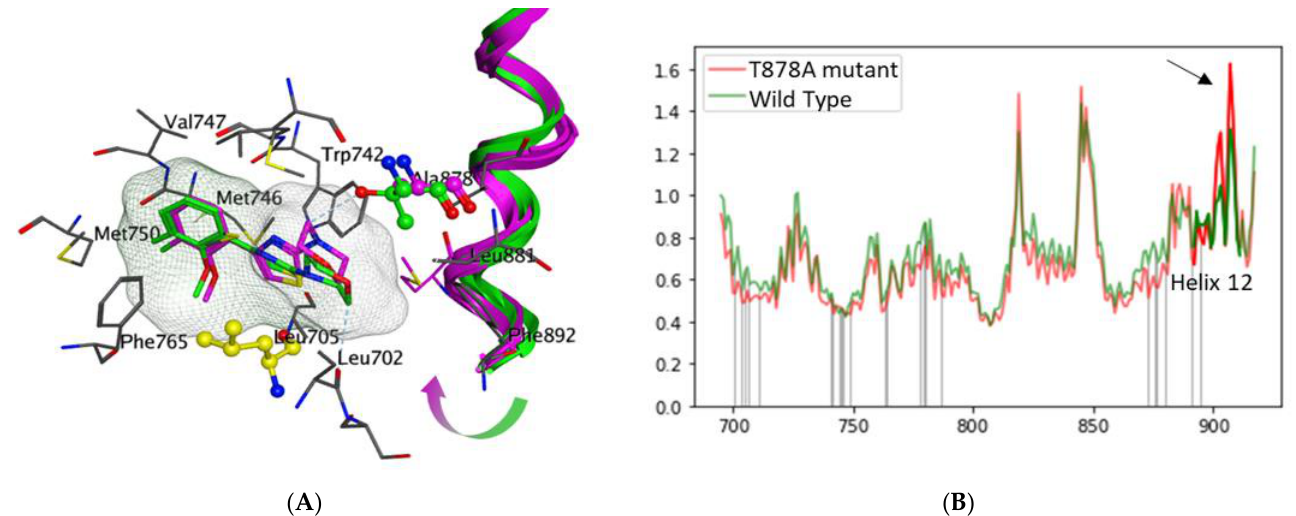
Figure 4. ( A ) Superimposition of helix 12 from MD clustered snapshots. Magenta – agonist; green – antagonist. The arrow shows that helix 12 shifts in the direction of the ligand binding site in the agonist state. Residue in yellow is L705. Note, VPC14368 in WT (green) is located closer to L705. A878 are also highlighted in ball and stick. ( B ) Per residue RMSD throughout the 500ns simulation averaged across 3 replicas. Residues of helix 12 are highlighted. The arrow points at the higher mobility of helix 12 in the mutant form (red).